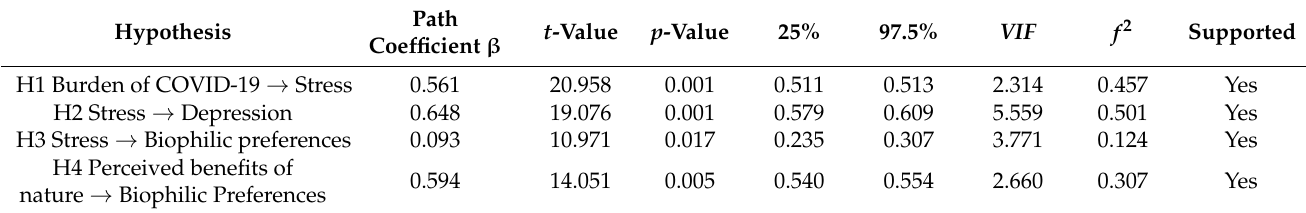
Table 5. Path analysis was used to test the hypothesis of direct